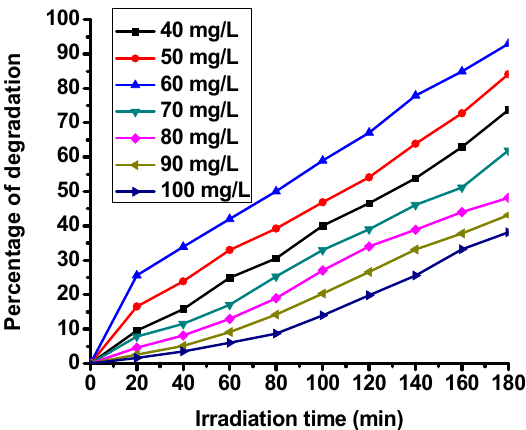
Figure 6. Optimization of the initial concentration of methyl red on the photocatalytic degradation using N-Cu 2 O/ZnO nanocomposite under sunlight.